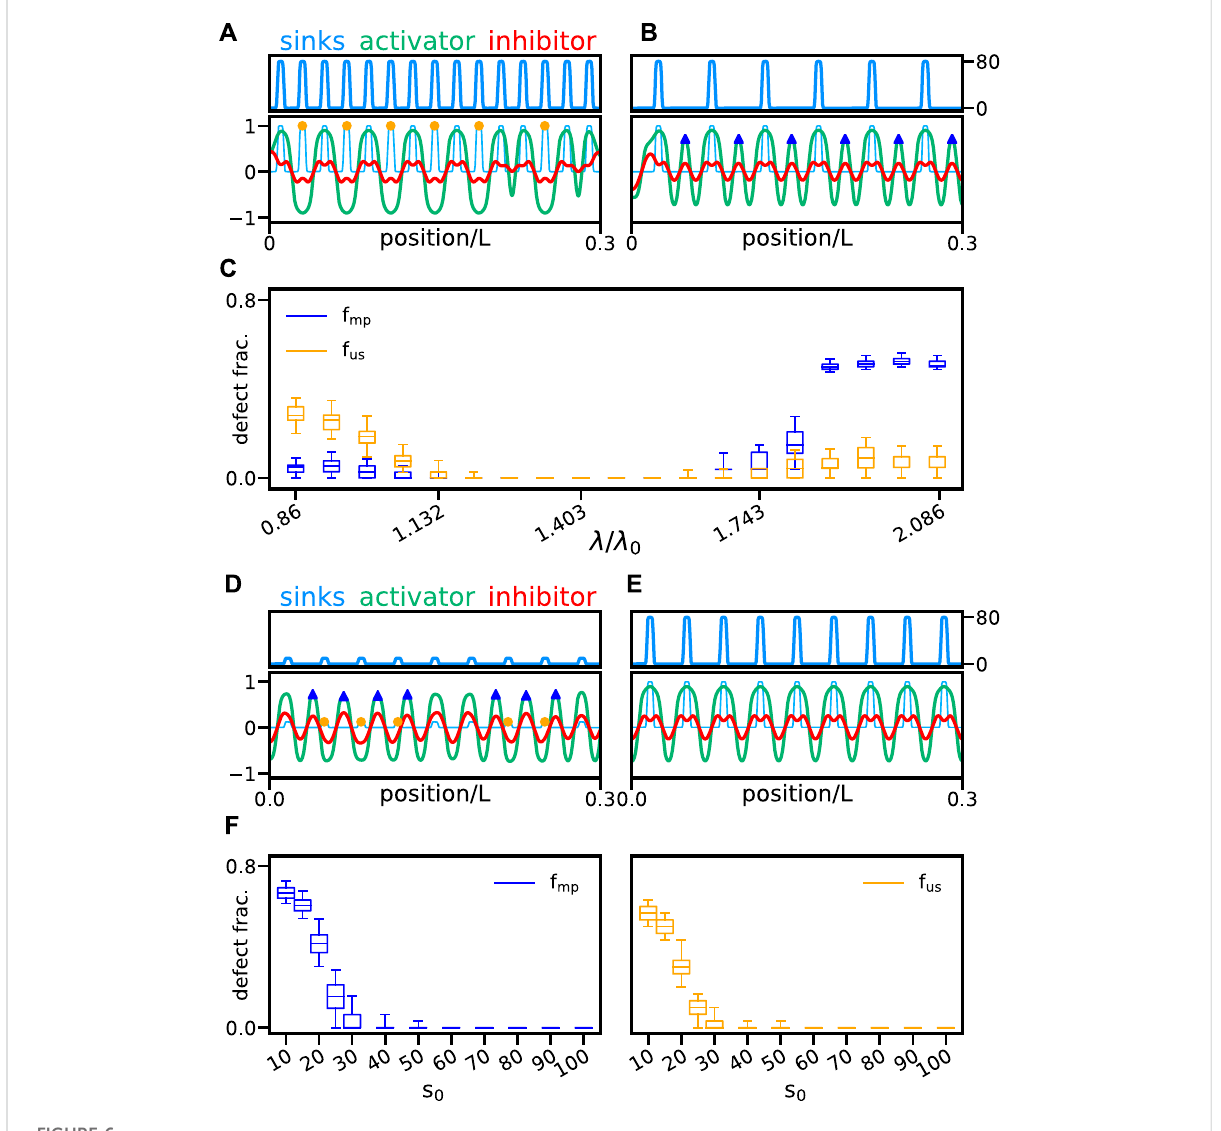
FIGURE 6 Sink pro fi le wavelength and strength. Activator (green line) and inhibitor (red line) patterns together with the scaled sink pro fi le (faint light blue line) are shown for sink pro fi les of wavelength (A) λ / λ 0 = 0.86 and (B) λ / λ 0 = 2.086. Here, λ 0 = 0.398 is the wavelength of the unforced pattern. Sink pro fi le(lightblueline)isalsoshownseparatelyinthetoppanelsforclarity. (C) Fractionofmisplacedpeaks f mp (blueboxplot)andunmatchedsinks f us (orange box plot) vs. relative sink pro fi le wavelength λ / λ 0 . Activator and inhibitor patterns for sink pro fi les of strength (D) s 0 = 10 and (E) s 0 = 80. Color coding and plot layout are as in panels (A and B) . (F) Fraction of misplaced peaks f mp (blue box plot) and unmatched sinks f us (orange box plot) vs.sinkpro fi lestrength s 0 .Boxplots in (C) and (F) areasinFigure 4.Other parameters areasinTable 1.Inall cases,weperformed300realizationsfor each parameter